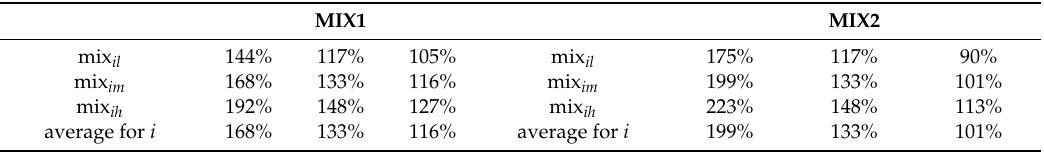
Table A11. Percentage of markup loss / treatment unit with dental charges constant for the 9 mixes under consideration in the two mix scenarios (MIX1 and MIX2).